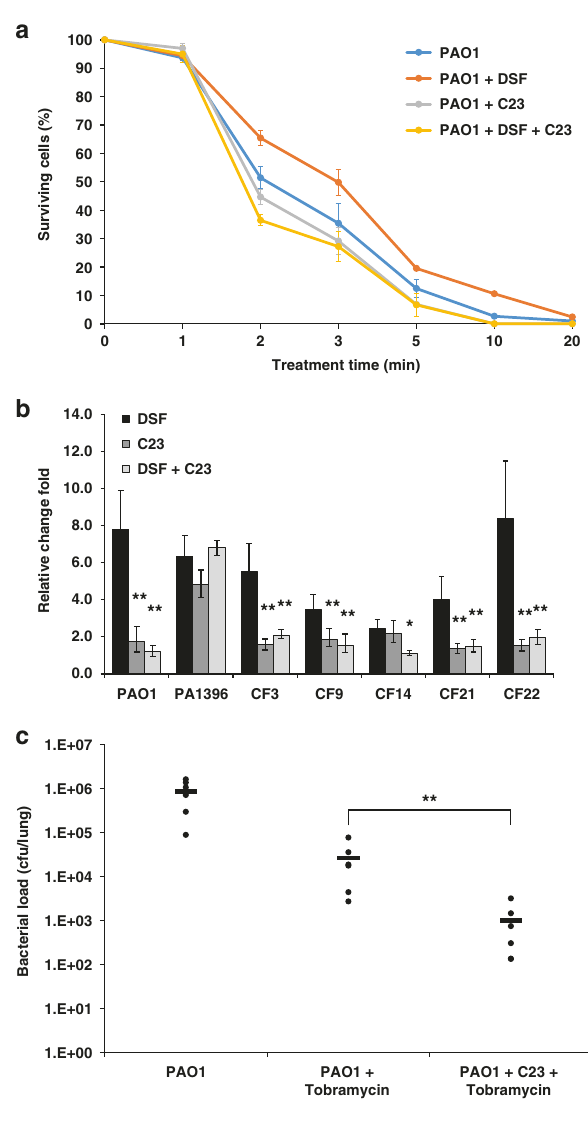
Fig. 6 Effects of DSF and C23 on antibiotic resistance of P. aeruginosa strains. a Effect of addition of DSF, C23, and DSF together with C23 on tolerance of P. aeruginosa to polymyxins. Time-courses of killing of P. aeruginosa by 4 μ g/ml polymyxin B were established for bacteria suspended in sodium phosphate buffer. Bacteria for these experiments were grown in BM2 medium with glucose supplemented with 2 mM Mg 2 + . DSF and C23 were added to these cultures to a fi nal concentration of 50 μ M. Values